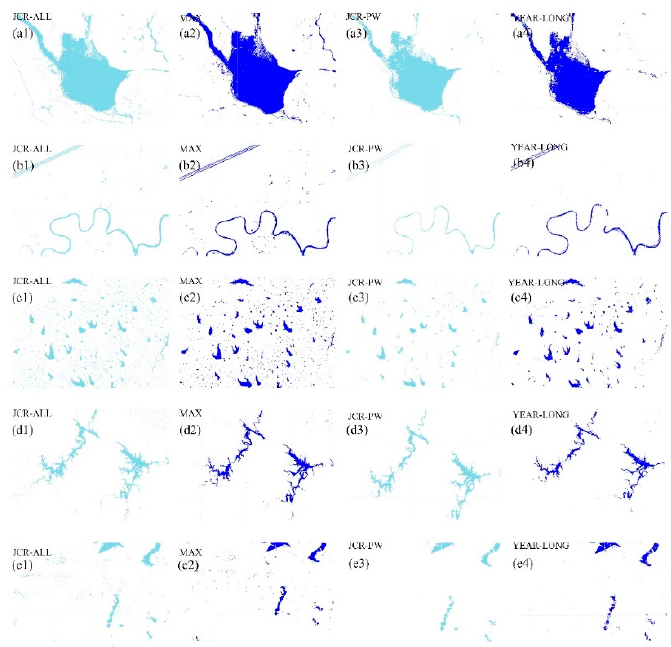
Figure 11. A comparison between the water map generated in this study (MAX ( a2 – e2 ) denotes the maximum water body, and YEAR-LONG ( a4 – e4 ) denotes the year-long water body) and JRC-data (JRC-All represents the sum of the annual seasonal surface water and permanent surface water ( a1 – e1 ), and JRC-PW represents permanent surface water of the JRC-data ( a3 – e3 ). Lakes ( a ), rivers ( b ), ponds ( c ), mountain waters ( d ) and urban water bodies ( e ).